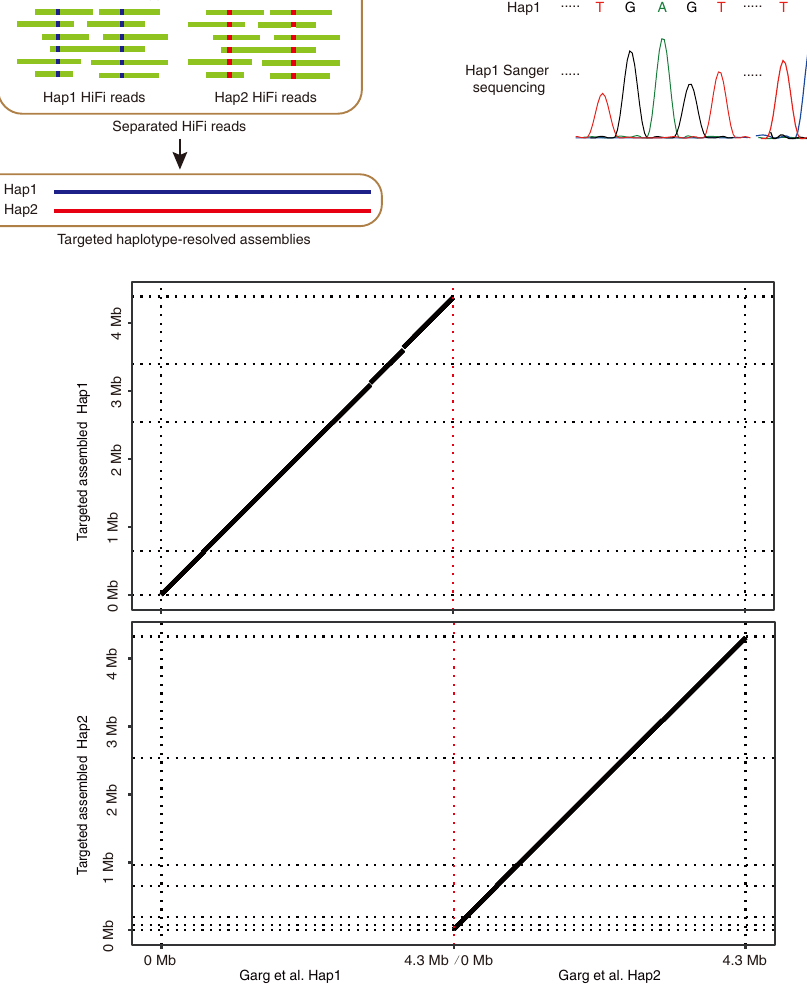
Sanger sequencing. The nucleotides different from the best-matching IMGT/HLA alleles are shown. The positions of the different nucleotides in the HLA-C gene are indicated. d The comparison between our targeted assembly and the MHC region from genome assembly reported previously 8 for each haplotype. The Y -axis indi- cates the coordinate of our targeted assembly, and the X -axis indicates the coor- dinate of Garg et al.